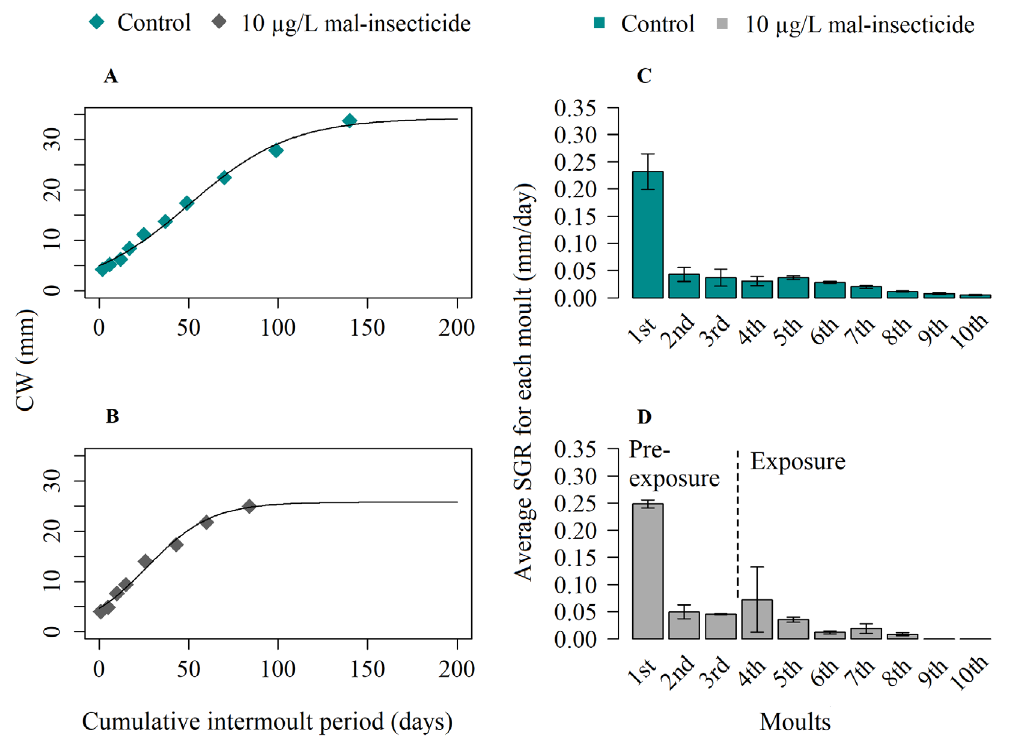
Figure 2. Growth curves for Poppiana dentata in relation to: variation in CW size (mm) over time (cumulative intermolt period) for control ( A ) and malathion-exposed ( B ) crabs over the 5-month period; mean specific growth rate (SGR) for control ( C ) and malathion-exposed ( D ) crabs for the same 5-month period. Error bars in C and D represent the standard errors for SGR. The dashed line in D separates the initial three molts under pre-exposure (no pesticide) conditions for the malathion-exposed cohort and those molts experienced during exposure to the malathion insecticide at 10 µg/L